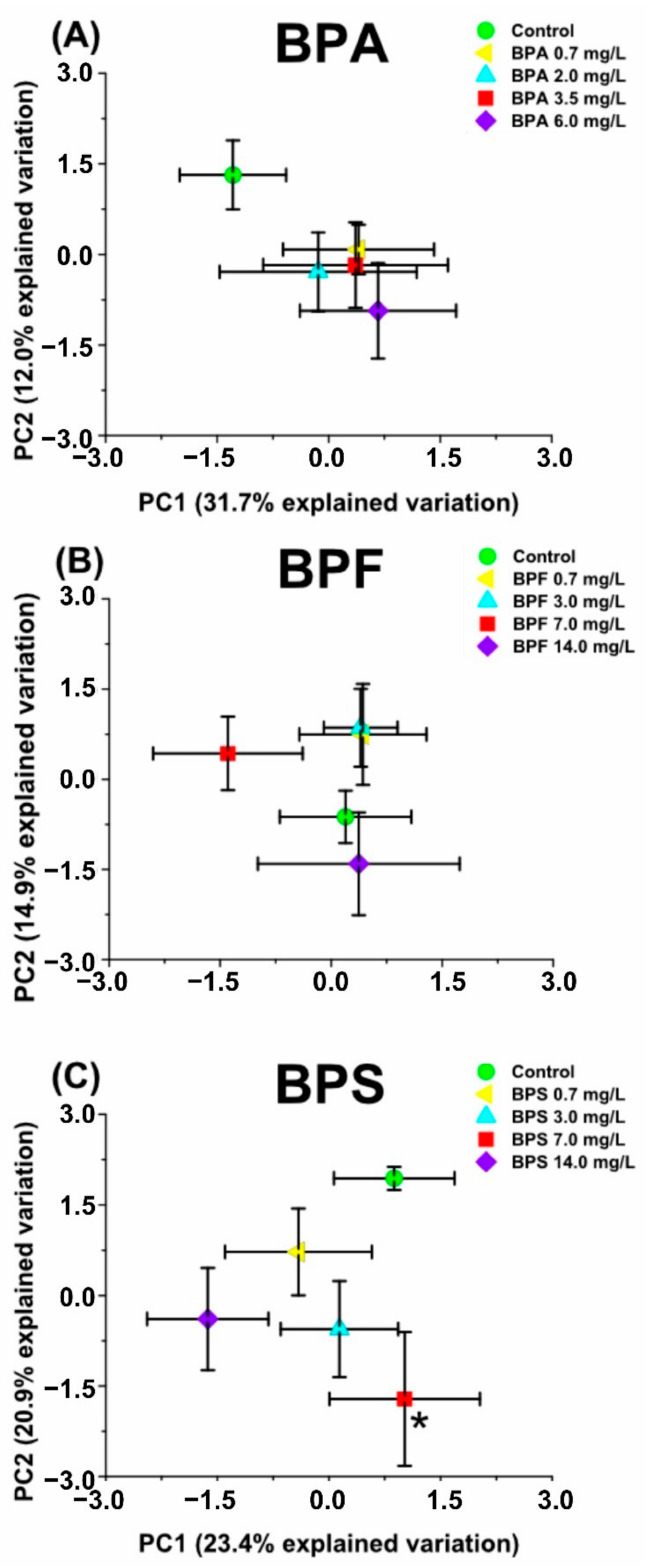
Figure 1. Averaged principal component analysis (PCA) score plots (PC 1 vs. PC2) of metabolic profiles of Daphnia magna exposed to ( A ) bisphenol A (BPA), ( B ) bisphenol F (BPF), and ( C ) bisphenol S (BPS). Averaged PCA scores are presented with their associated standard errors. Statistically significant separation from the control group ( p ≤ 0.05) is indicated with an asterisk (*) close to the exposure group